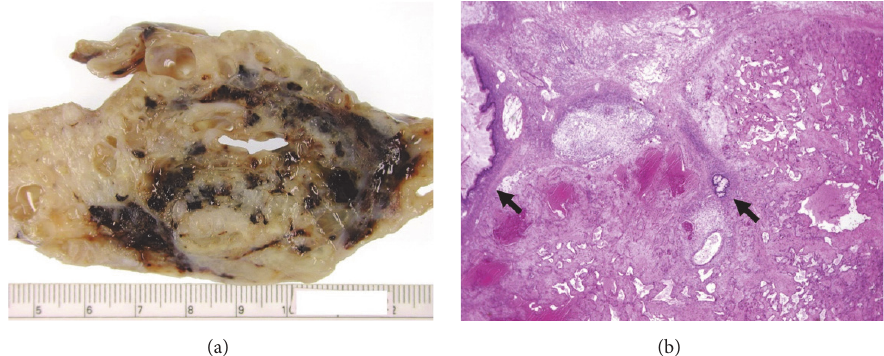
Figure 1: Macroscopic and intraoperative histologic appearance of ovarian tumor. (a) A confluence of hemorrhagic foci in spongy to solid portion of ovarian cystic mass. (b) Ectatic anastomosing vascular spaces in the frozen section sample; arrows indicating mucinous cyst lining (defrosted tissue; hematoxylin and eosin [H&E] stain: ×